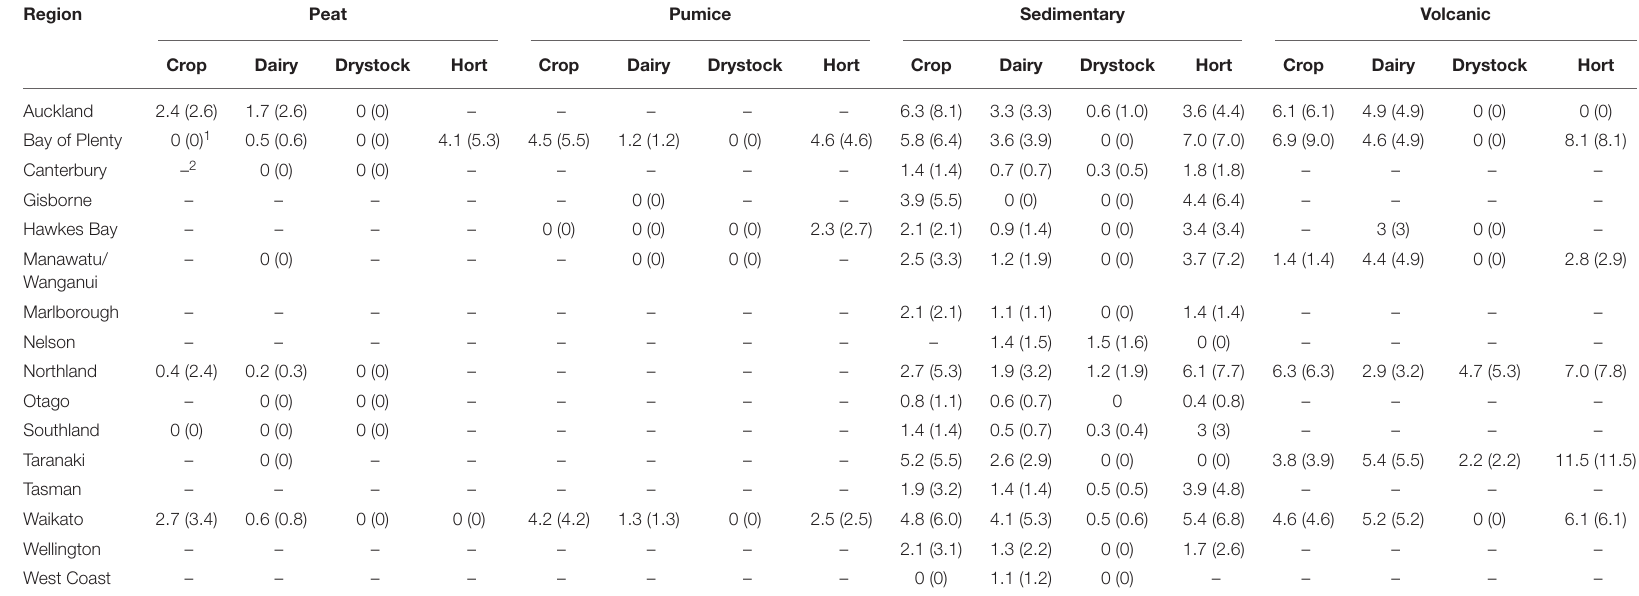
TABLE 3 | Median and the 75th percentile (in parentheses) of the time (years) taken for Olsen P to decrease to agronomic targets in each region by soil group by land use (Crop = Cropping, Hort = horticulture) combination if fertilizer P was withheld. Region Peat Pumice Sedimentary Volcanic Crop Dairy Drystock Hort Crop Dairy Drystock Hort